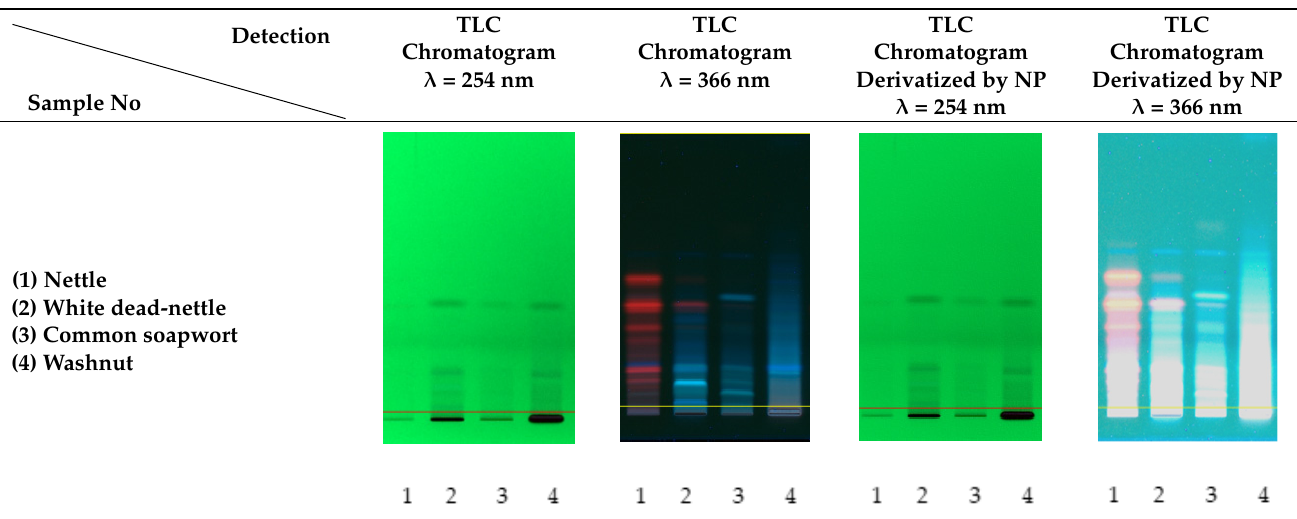
Table 2. Comparative analysis of extracts from the studied plants.